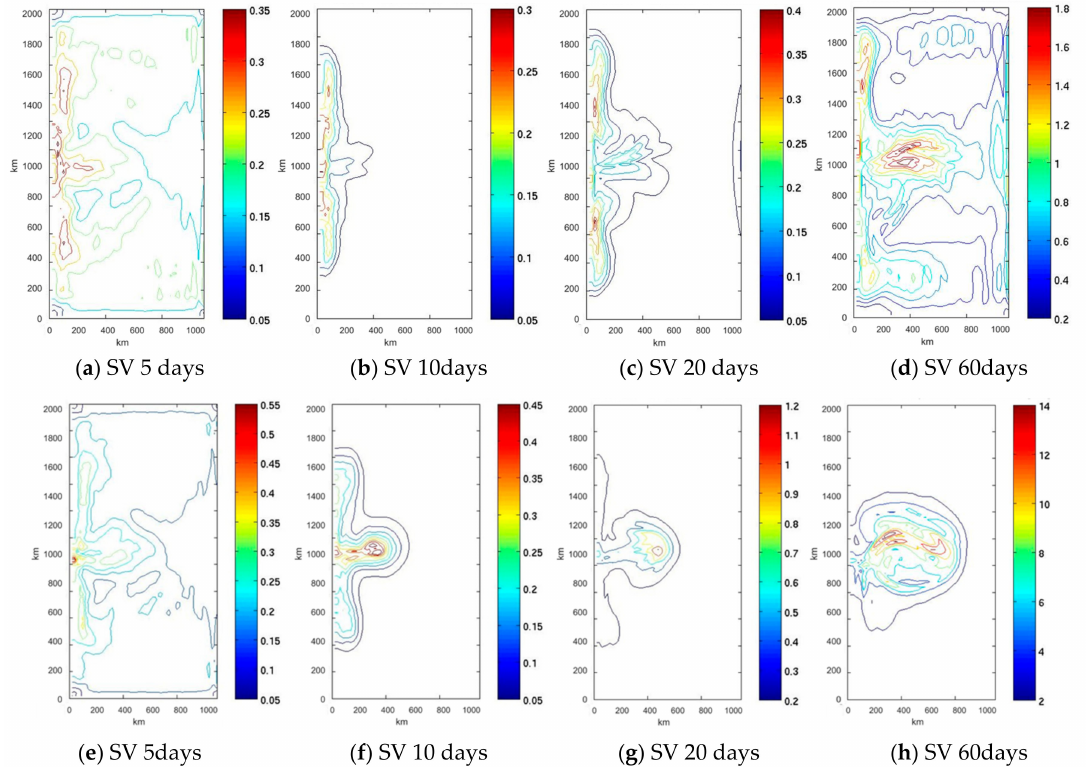
Figure 3. Sum of projections on the horizontal surface velocities of the 200 dominant initial singular vectors, for di ff erent optimization times ( a – d ). Similar sum of projections computed for the first 200 final singular vectors ( e – h ). Singular values are used to weight Singular Vectors